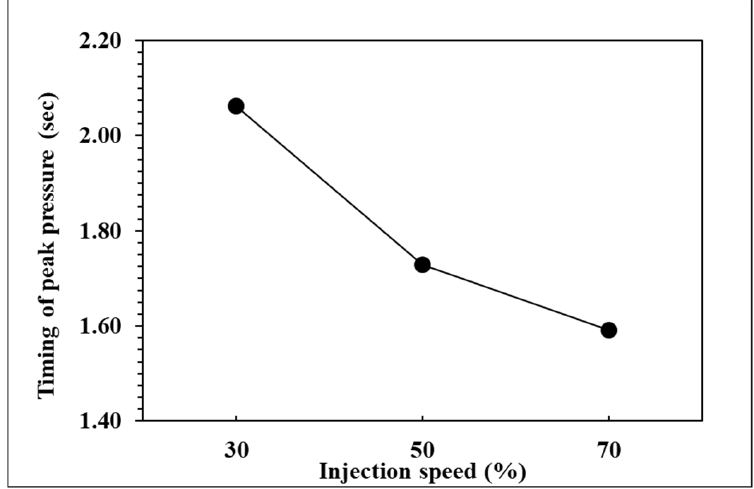
Figure 14. Relationship between peak pressure and injection speed.